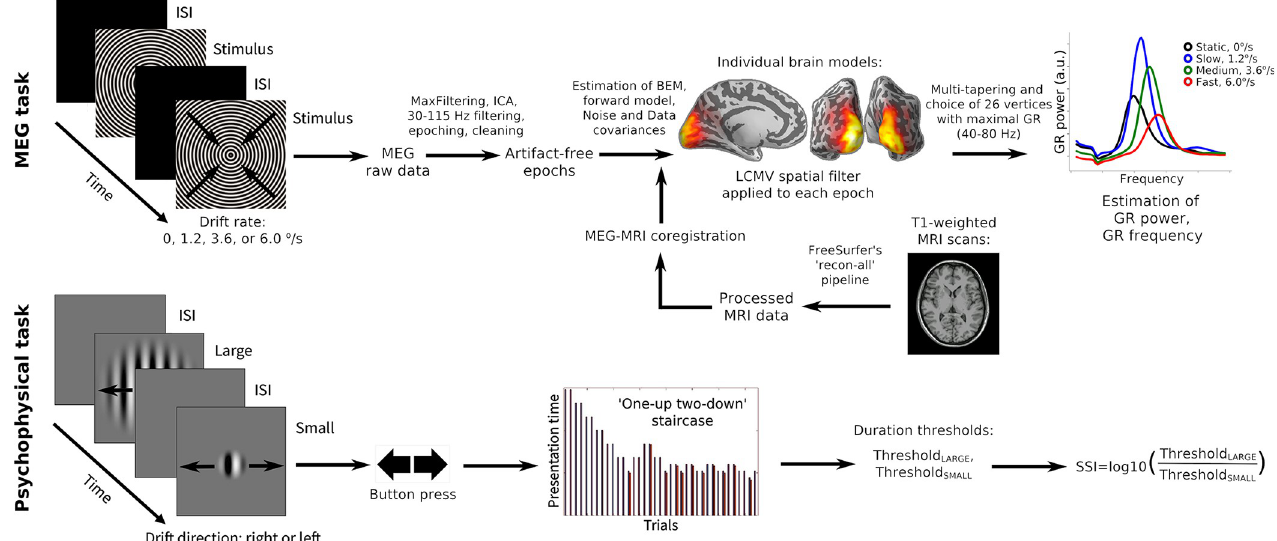
Fig 1. Schematic representation of experimental procedures and analysis of MEG (upper panel) and psychophysical data (lower panel). For a detailed description of the experimental procedures and analysis pipelines, see the Methods section. The procedures were identical between the two visits. ISI–inter- stimulus